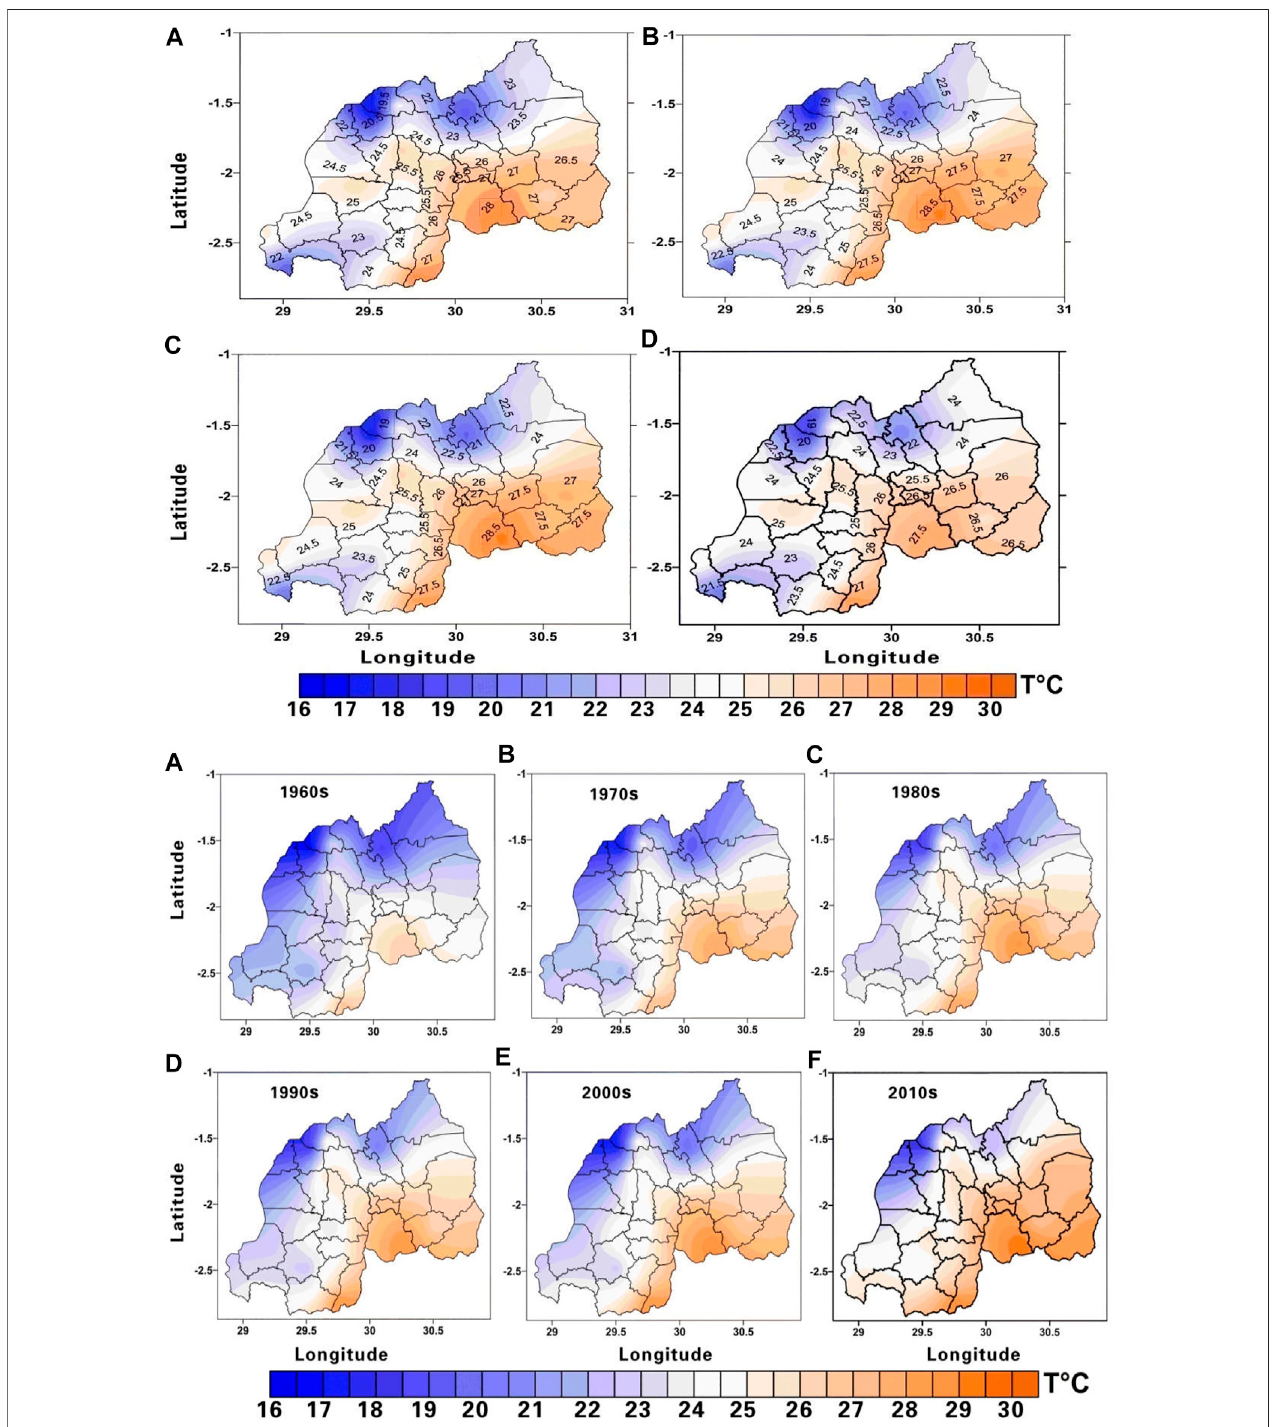
FIGURE4a | Spatial distribution ofseasonal and annual Tmax over Rwanda during 1961 – 2014; (A) Annual, (B) MAM, (C) JJA, (D) OND and Spatial distribution of Decadal Tmax over Rwanda during 1961 – 2014; (A) 1961, (B) 1970, (C) 1980, (D) 1990, (E) 2000, (F) 2010. T stands for temperature.